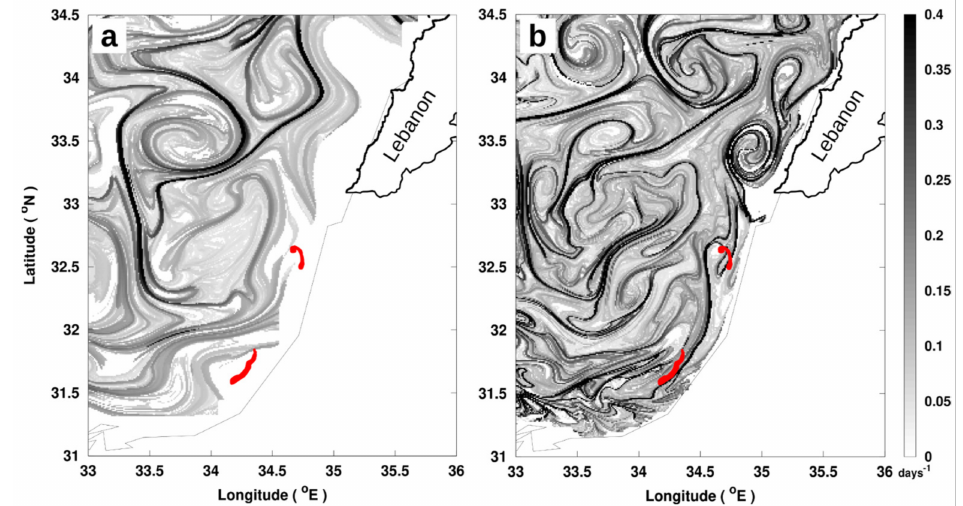
Figure 10. Comparison between Lagrangian fronts (gray) ( a ) derived from altimetry and ( b ) derived from the Mediterranean circulation model. The red patterns in ( a , b ) represent the position of the oil slicks on the 12th of February 2021.